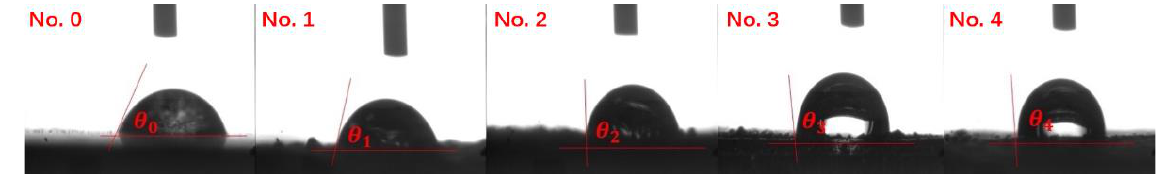
Figure 10. Contact angle measurement of LCC specimens No. 0 – 4.